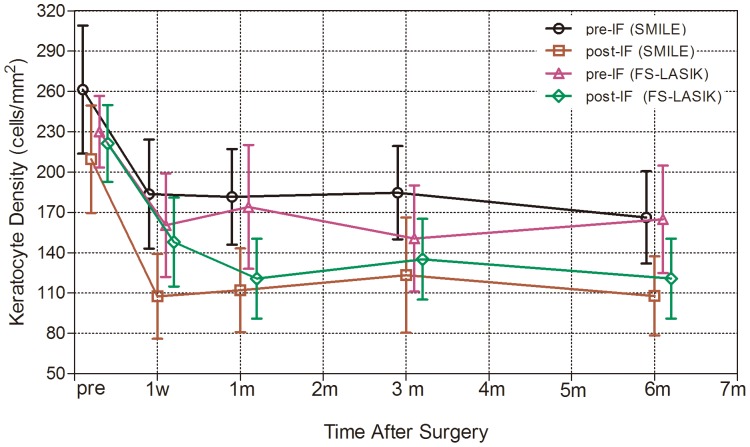
Time-dependent changes in the keratocyte density over time.